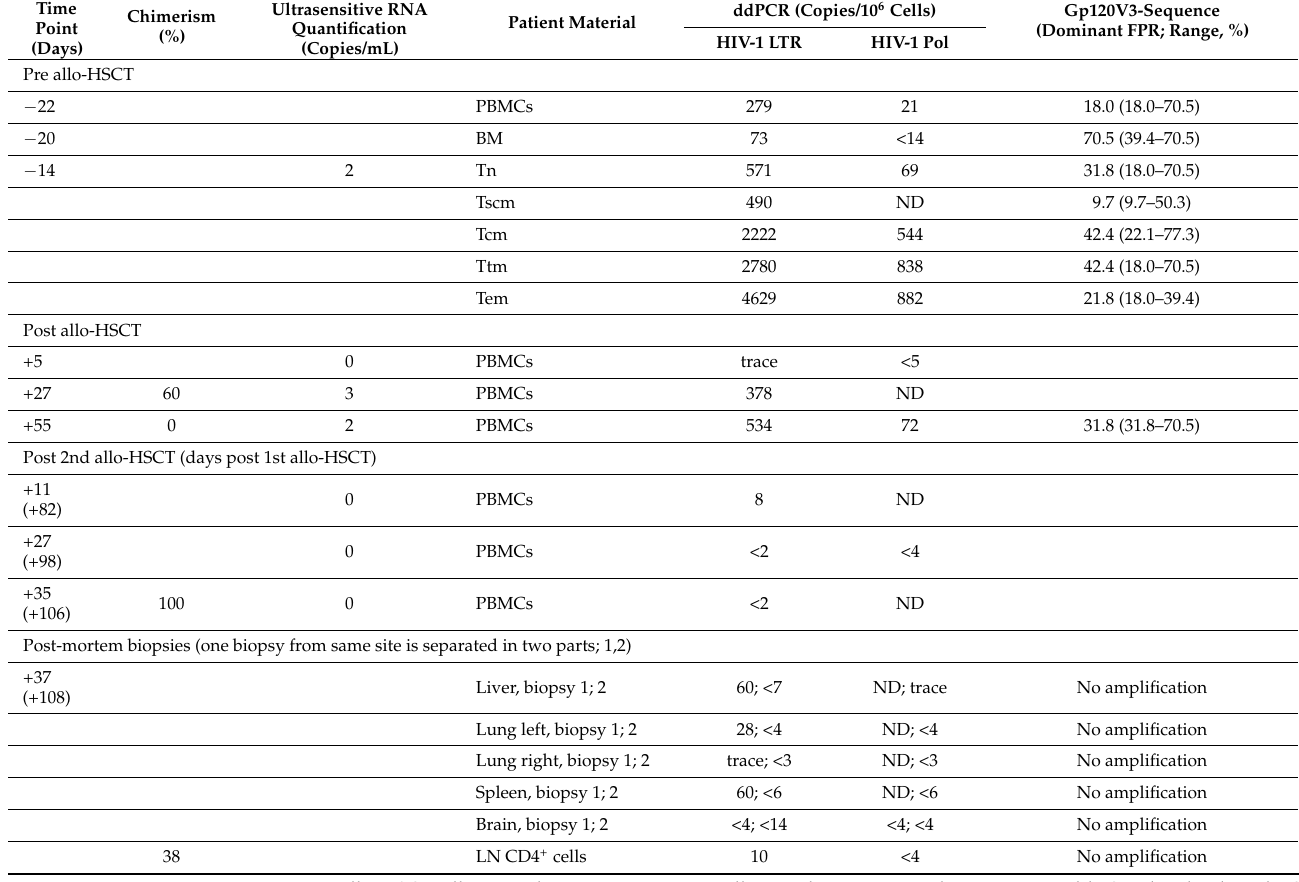
Table 3. Results of HIV-1-DNA quantification and characterization in patient